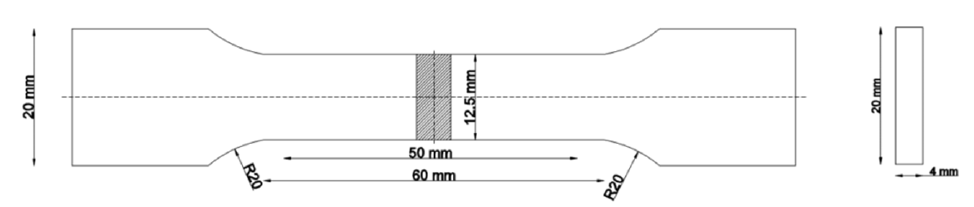
Figure 8. Tensile test specimen (mm).